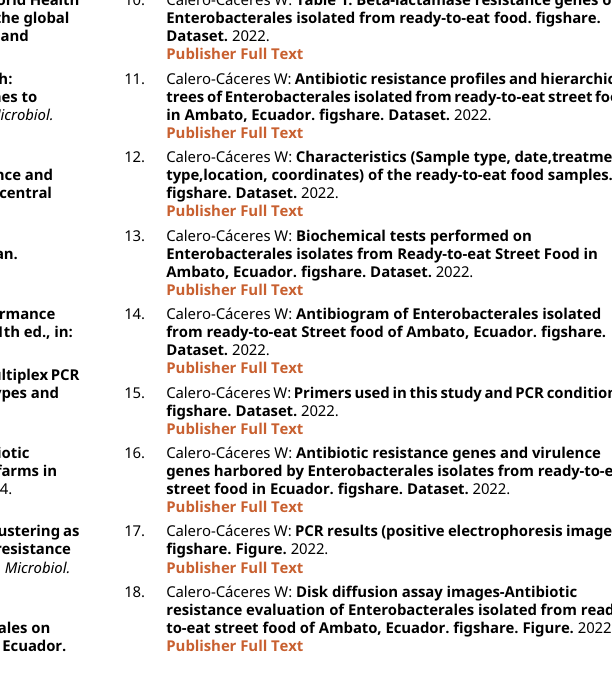
10. Calero-Cáceres W: Table 1. Beta-lactamase resistance genes of Enterobacterales isolated from ready-to-eat food. figshare. Dataset. 2022. Publisher Full Text 11. Calero-CáceresW: Antibioticresistanceprofilesandhierarchical treesofEnterobacteralesisolatedfromready-to-eatstreetfood in Ambato, Ecuador. figshare. Dataset. 2022. Publisher Full Text 12. Calero-Cáceres W: Characteristics (Sample type, date,treatment type,location, coordinates) of the ready-to-eat food samples. figshare. Dataset. 2022. Publisher Full Text 13. Calero-Cáceres W: Biochemical tests performed on Enterobacterales isolates from Ready-to-eat Street Food in Ambato, Ecuador. figshare. Dataset. 2022. Publisher Full Text 14. Calero-Cáceres W: Antibiogram of Enterobacterales isolated from ready-to-eat Street food of Ambato, Ecuador. figshare. Dataset. 2022. Publisher Full Text 15. Calero-CáceresW: PrimersusedinthisstudyandPCRconditions. figshare. Dataset. 2022. Publisher Full Text 16. Calero-Cáceres W: Antibiotic resistance genes and virulence genesharbored byEnterobacterales isolatesfromready-to-eat street food in Ecuador. figshare. Dataset. 2022. Publisher Full Text 17. Calero-CáceresW: PCRresults(positiveelectrophoresisimages). figshare. Figure. 2022. Publisher Full Text 18. Calero-Cáceres W: Disk diffusion assay images-Antibiotic